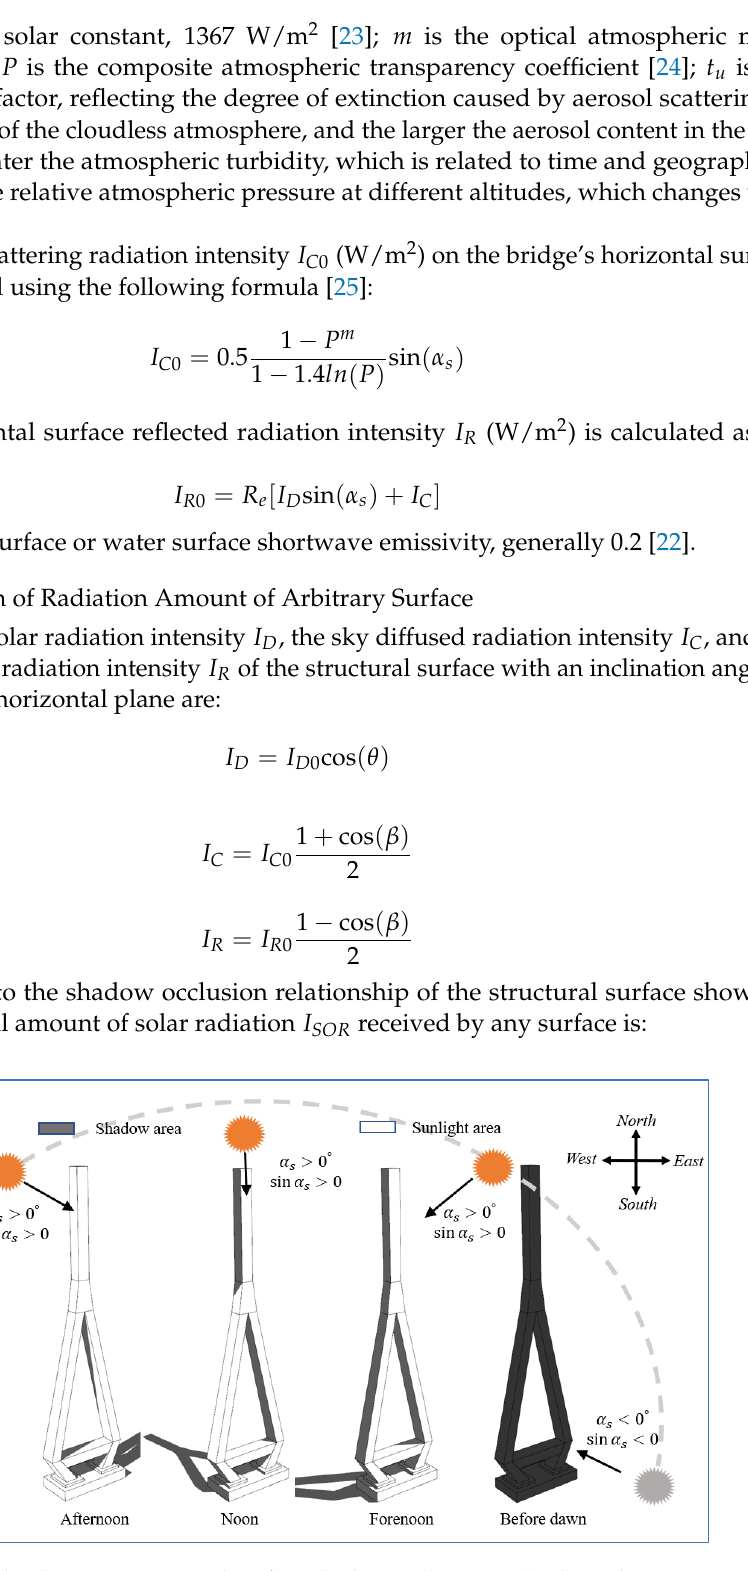
Figure 3. Relationship between structural surface shadow occlusion and solar